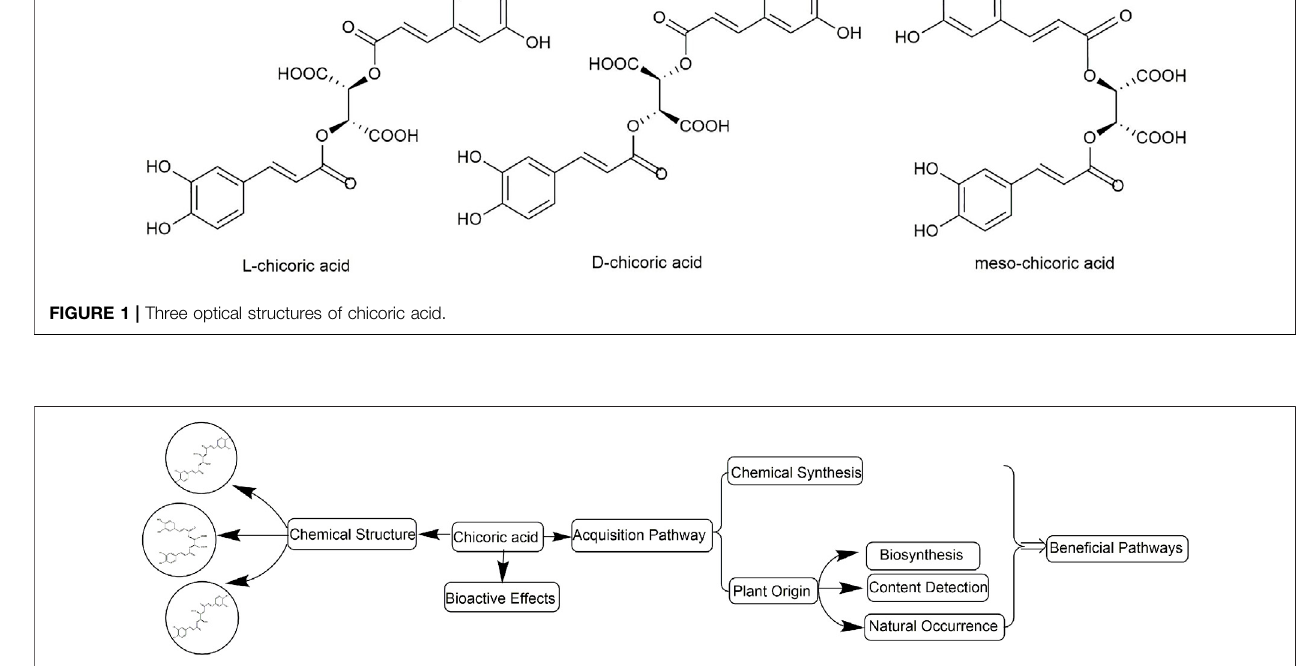
FIGURE 2 | Chemical structure, bioactive effects, and acquisition pathways of chicoric